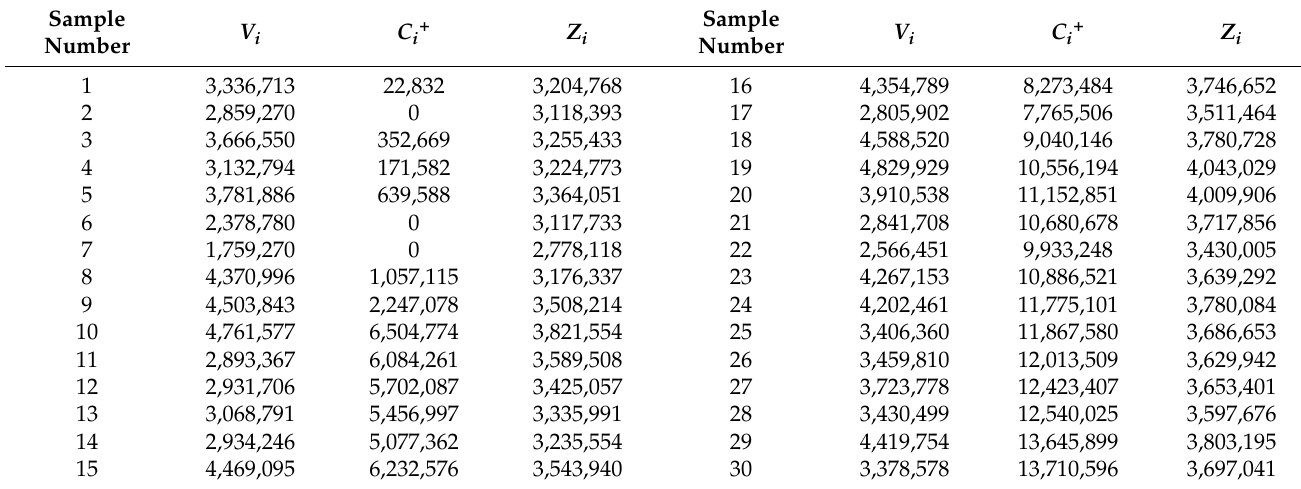
Table 7. Charting statistics for various control